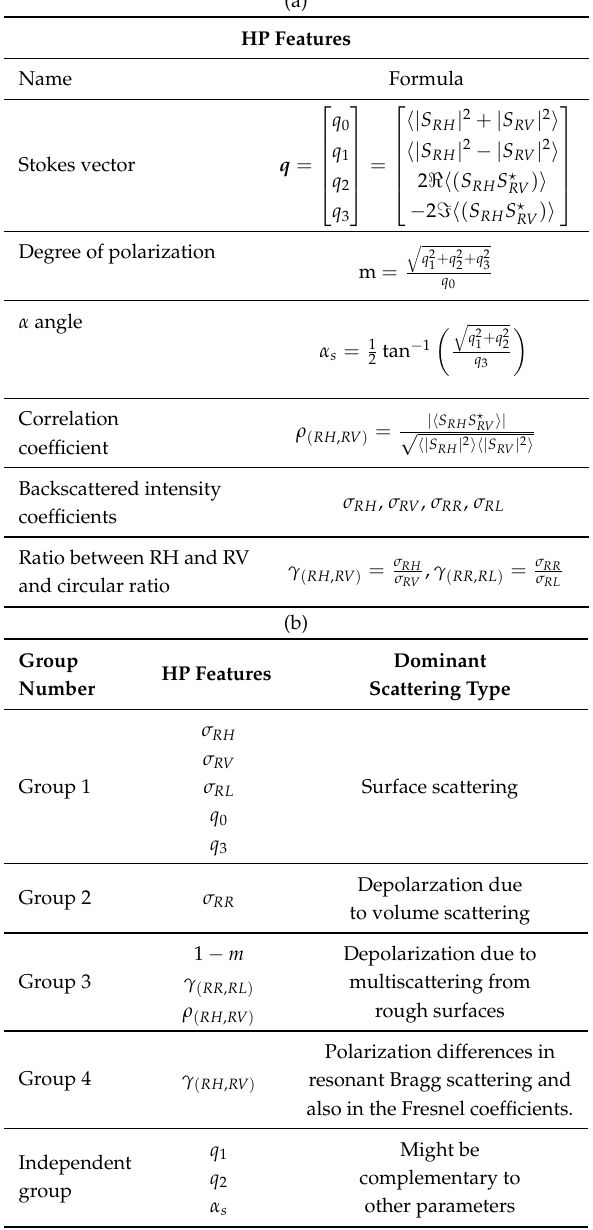
Table 3. (a); an overview of the investigated hybrid-polarity (HP) features [5,9,26,30,31]. (b); the HP features sorted into groups. The features within a group have common scattering types that they are predominately sensitive to (see